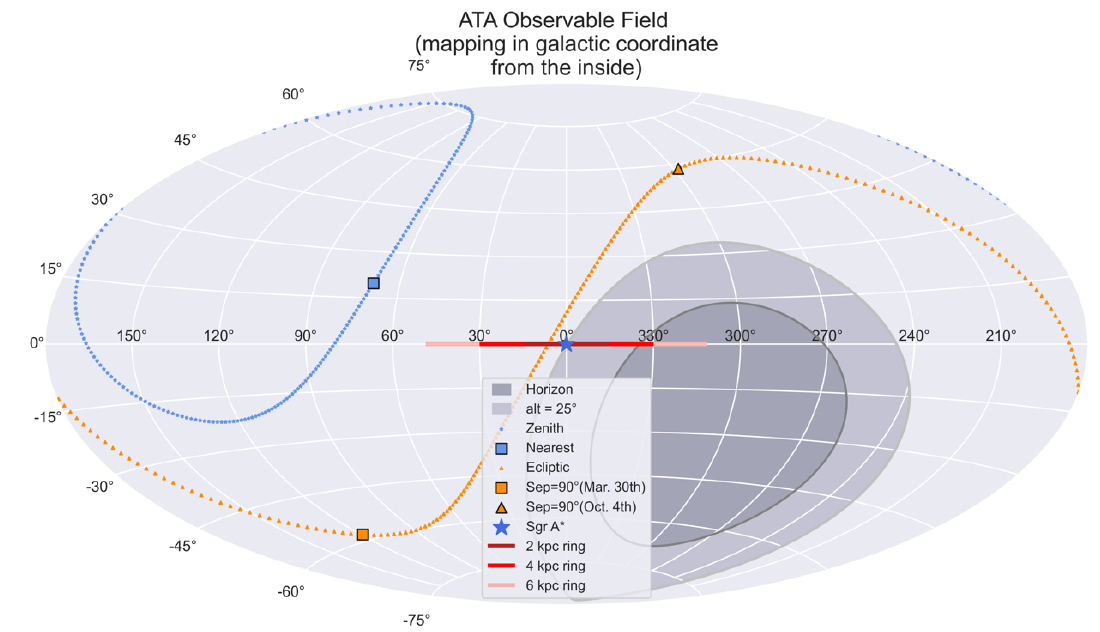
Figure 5. Observable Field of ATA.